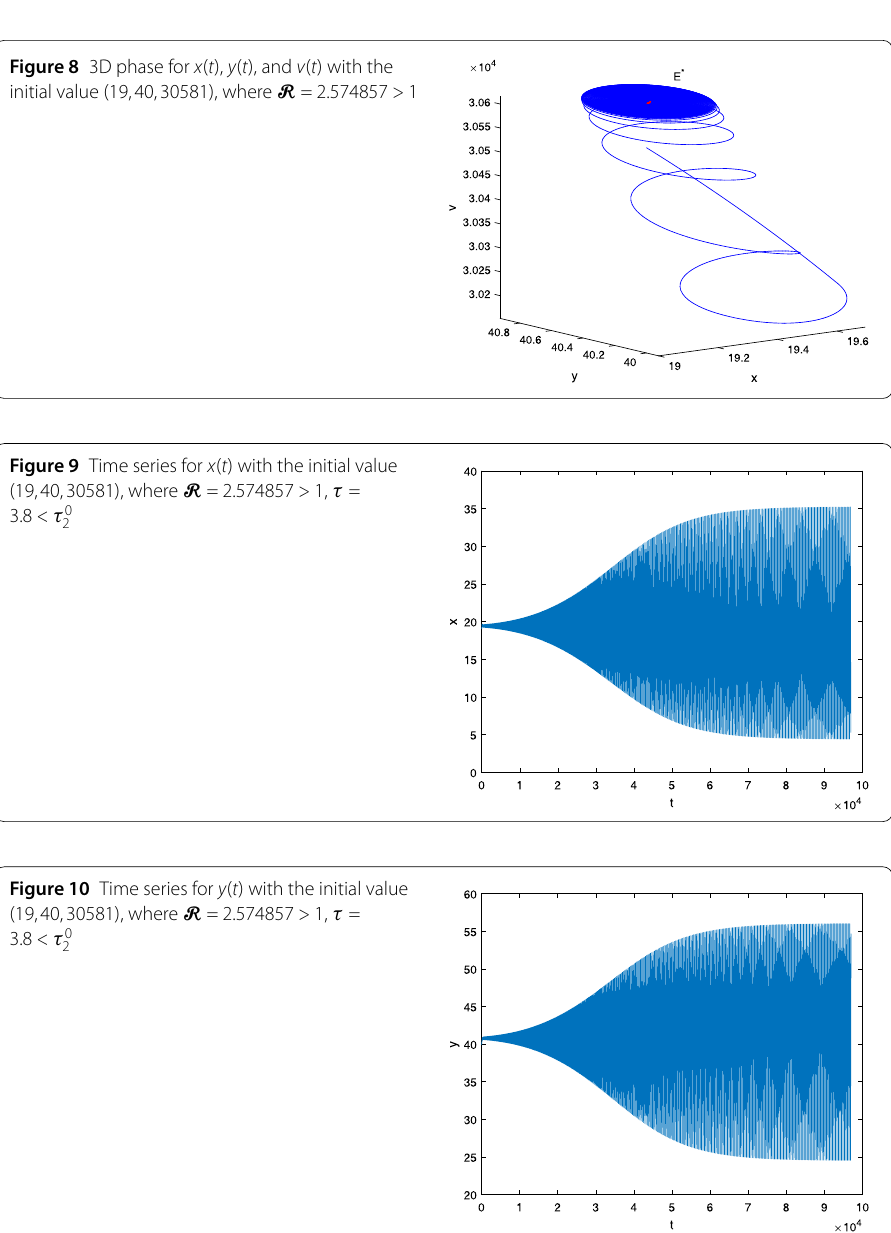
Figure 10 Time series for y ( t ) with the initial value (19,40,30581), where R = 2.574857 > 1, τ = 3.8 < τ 0